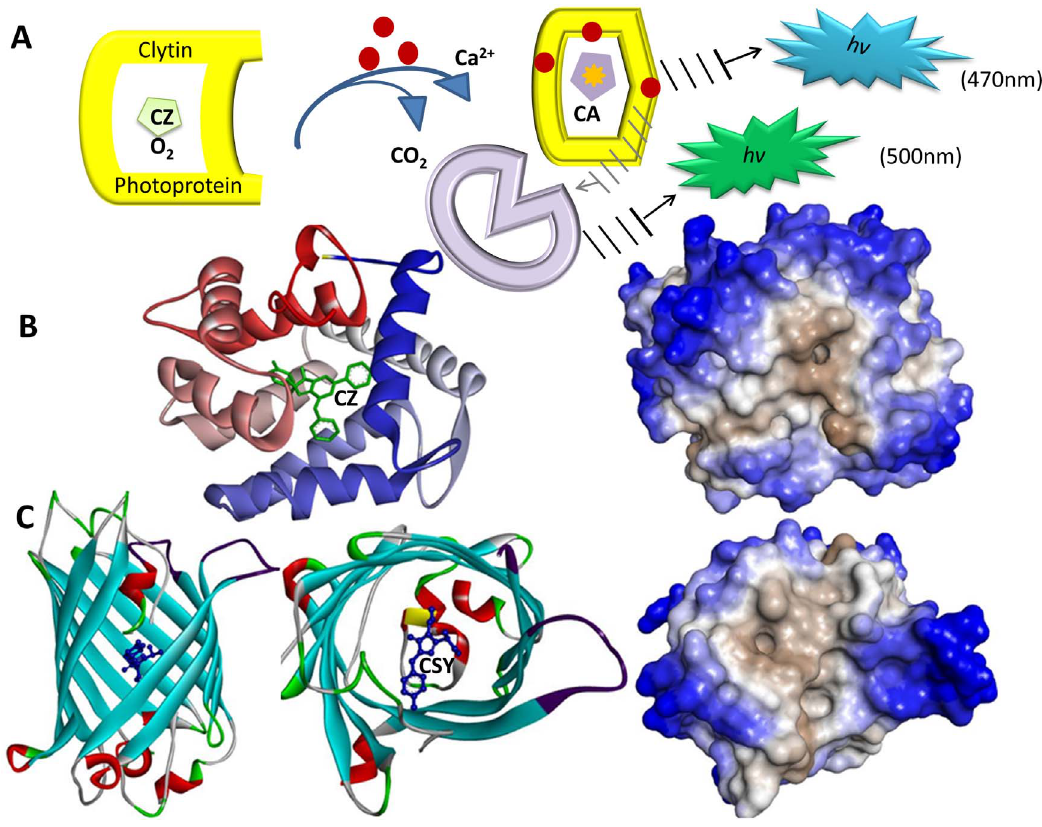
Figure 7. Bioluminescence system of the jellyfish Clytia with the GFP-clytin complex. (A) Clytin is a Ca 2 + -regulated photoprotein comprising coelenterazine (CZ) as a substrate for its bioluminescence reaction. When Ca 2 + binds to clytin, the bioluminescence reaction is triggered to produce the excited state product coelenteramide (CA) and CO 2 with emission of a broad blue bioluminescence (maximum 470 nm). Due to energy transfer, Clytia GFP fluorescence is in green (maximum 500 nm). (B) The structure of clytin (22.4 kDa, PDB code 3KPX) and its representation using hydrophilic (outer part in blue) and hydrophobic (inner part) residues. (C) The structure of Clytia GFP (PDB code 2HPW) and its representation using hydrophilic and hydrophobic residues using Discovery Studio 3.5. The visible fluorophore of Clytia GFP (CSY) is a sequence of three amino acids (68S, 69Y, and 70G). To protect the chromophore fluorescence from quenching by water, the tightly packed nature of the barrel excludes solvent molecules resulting in that the environment comprising this fluorophore is also